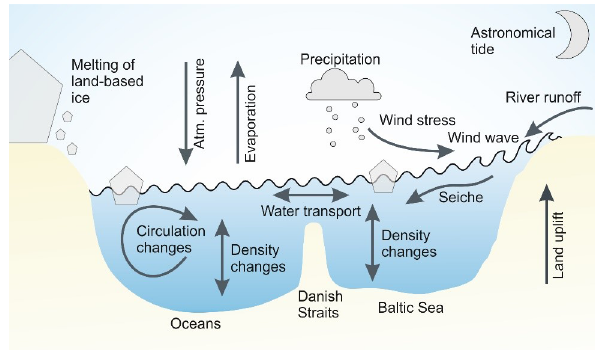
Figure 3. Processes contributing to sea level variability and change in the Baltic Sea (redrawn and modified from Johansson, 2014).